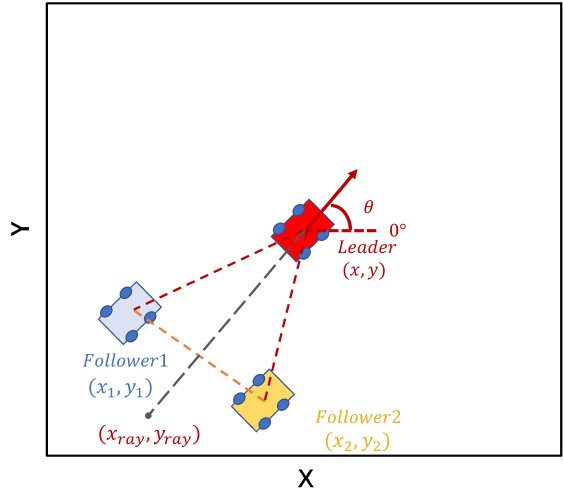
Figure 7. Illustration of the formation position reward